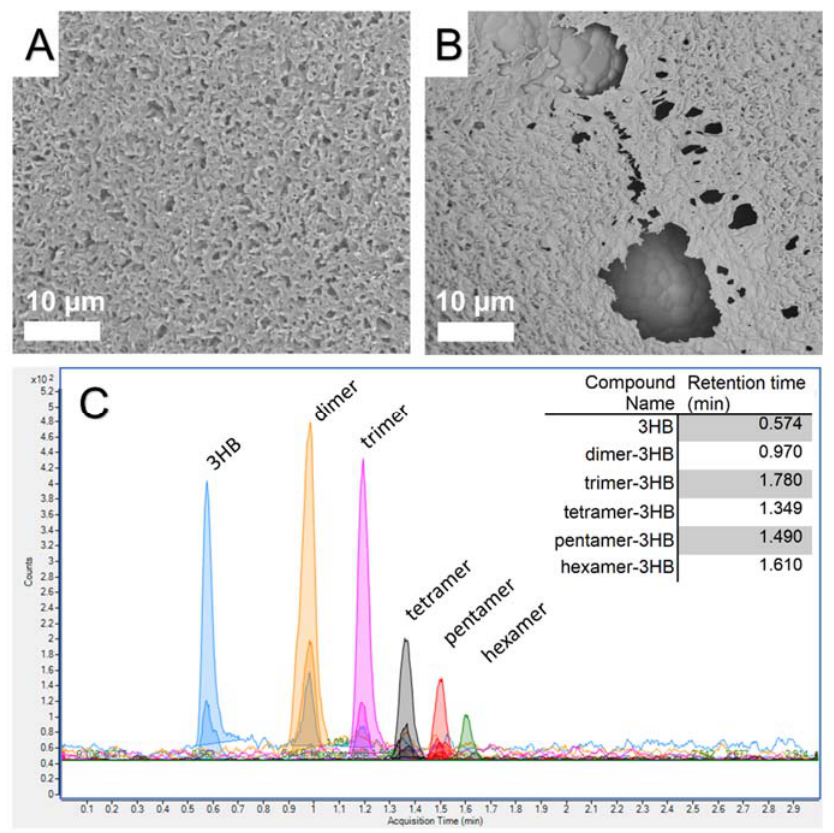
Figure 6. SEM microphotograph of the surface of the TCP/P(3HB) composite before ( A ) and after 120 days incubation in distilled water ( B ). The results of UHPLC-MS analysis ( C ).